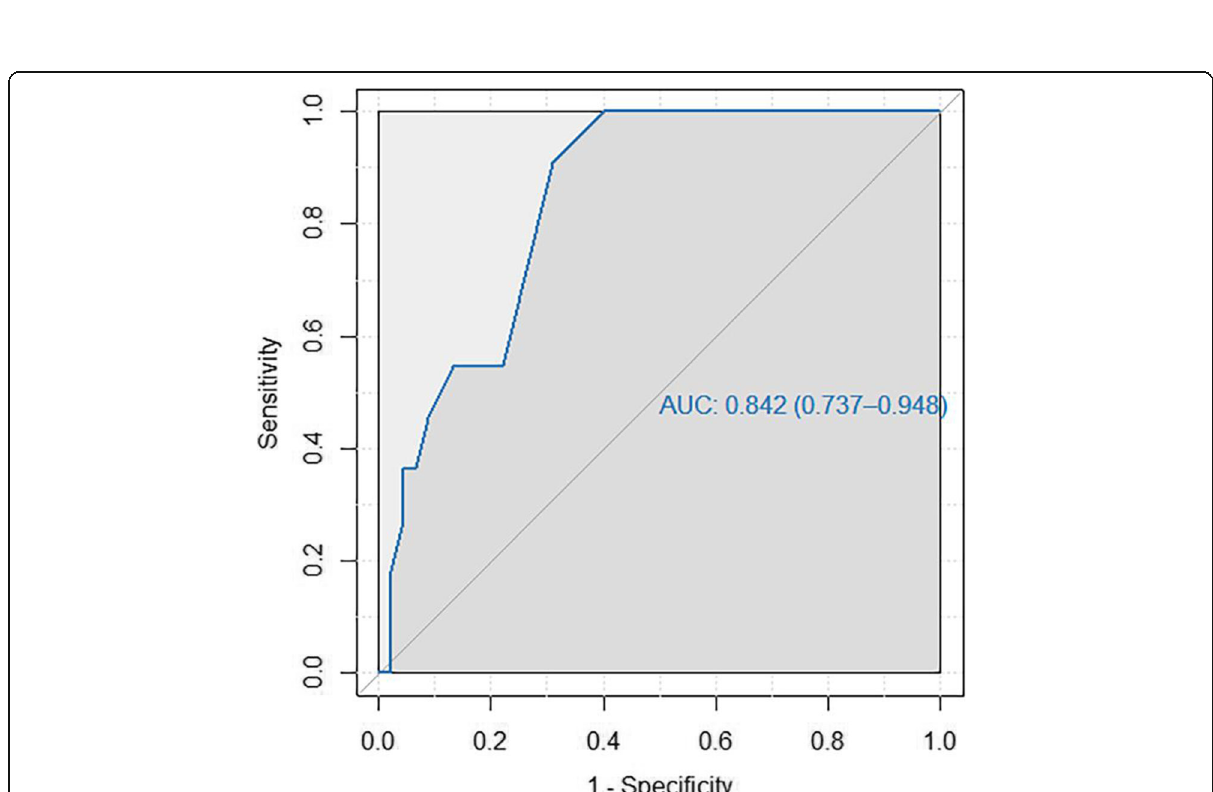
Fig. 3 ROC curve to test the cut-off point of CT severity score between the mild group and severe